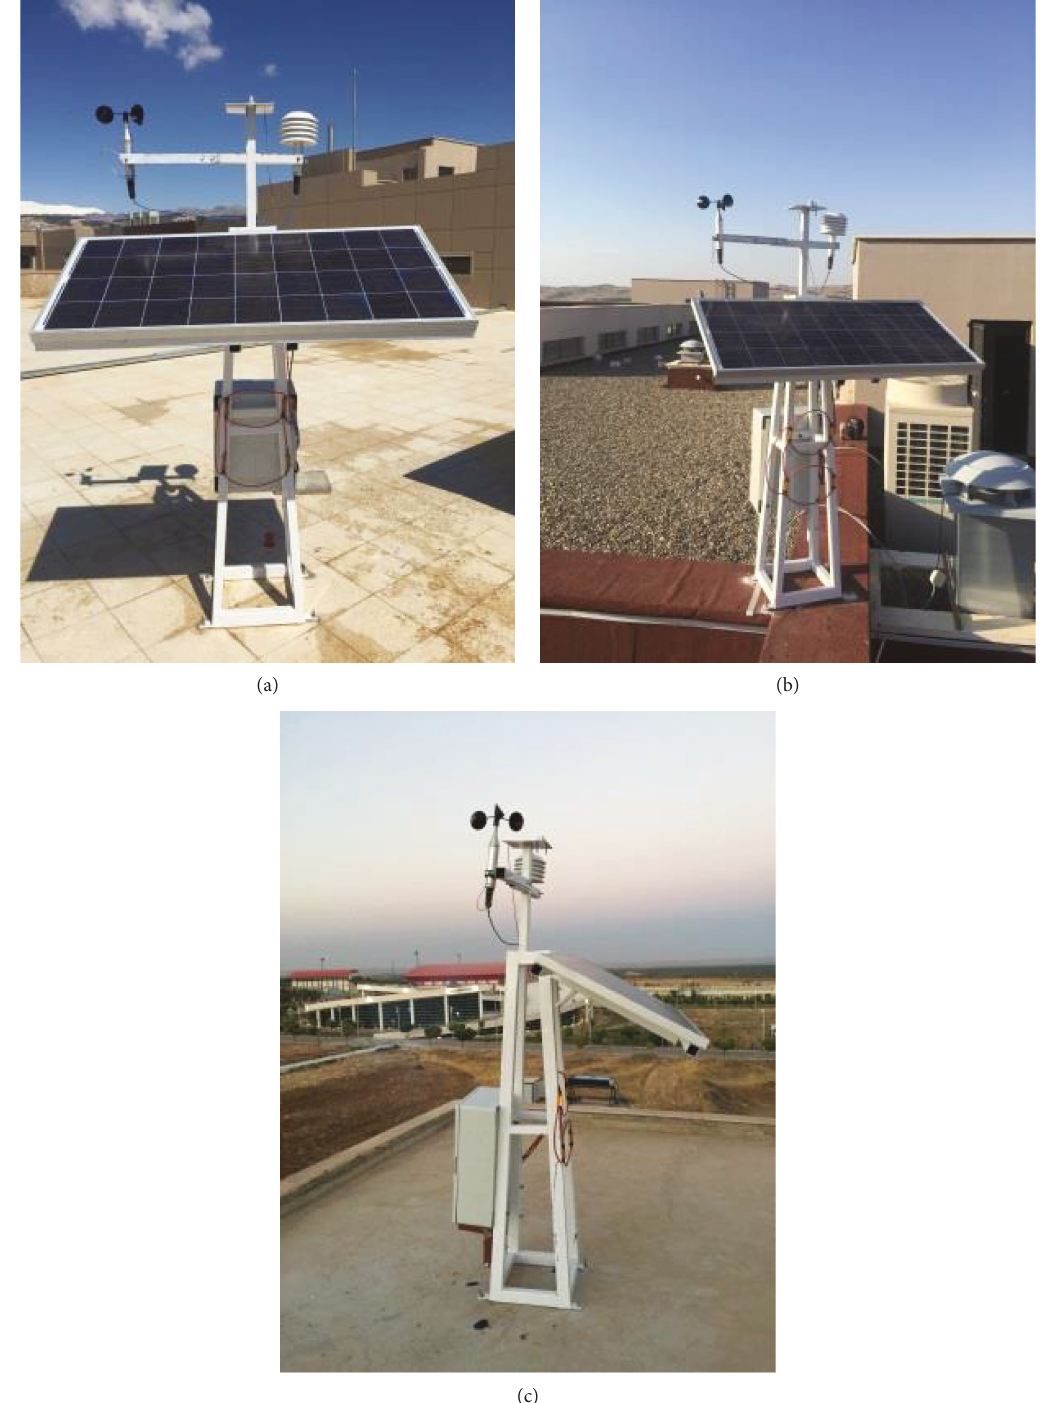
Figure 3: Application images of terminal measurement station (a) Adiyaman, (b) Malatya, and (c)